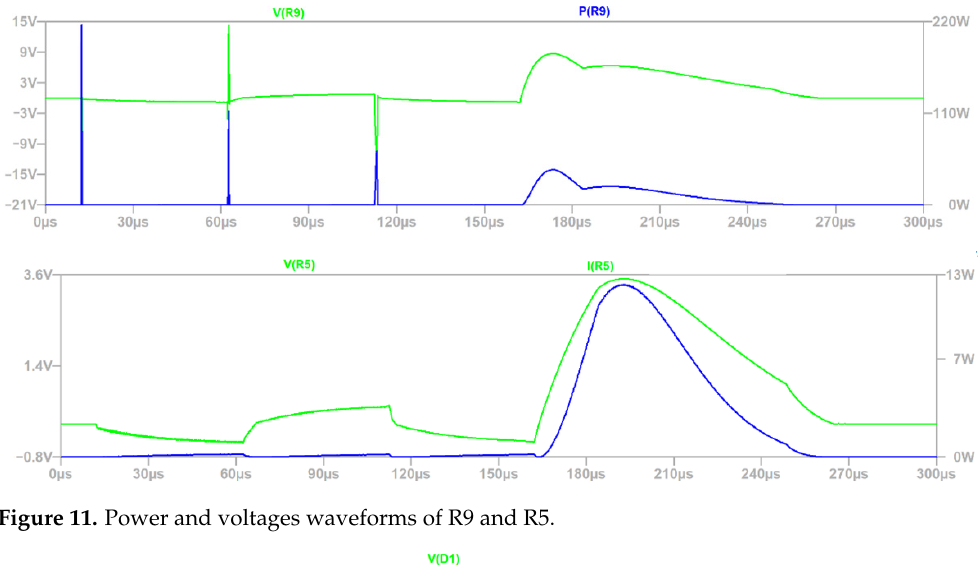
Figure 11. Power and voltages waveforms of R9 and R5.